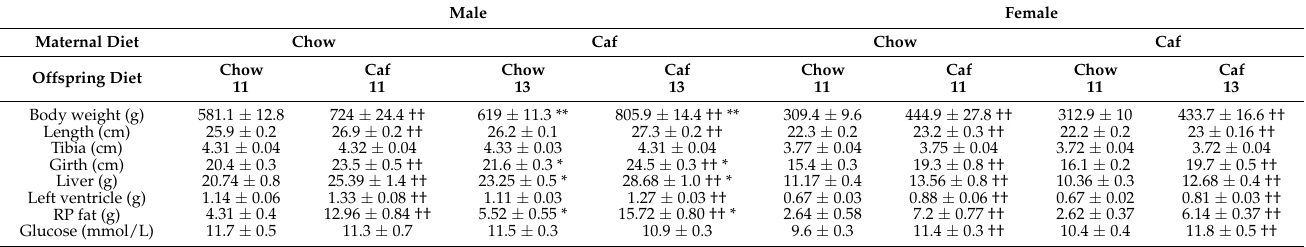
Table 4. Offspring endpoint measures at 14 weeks.